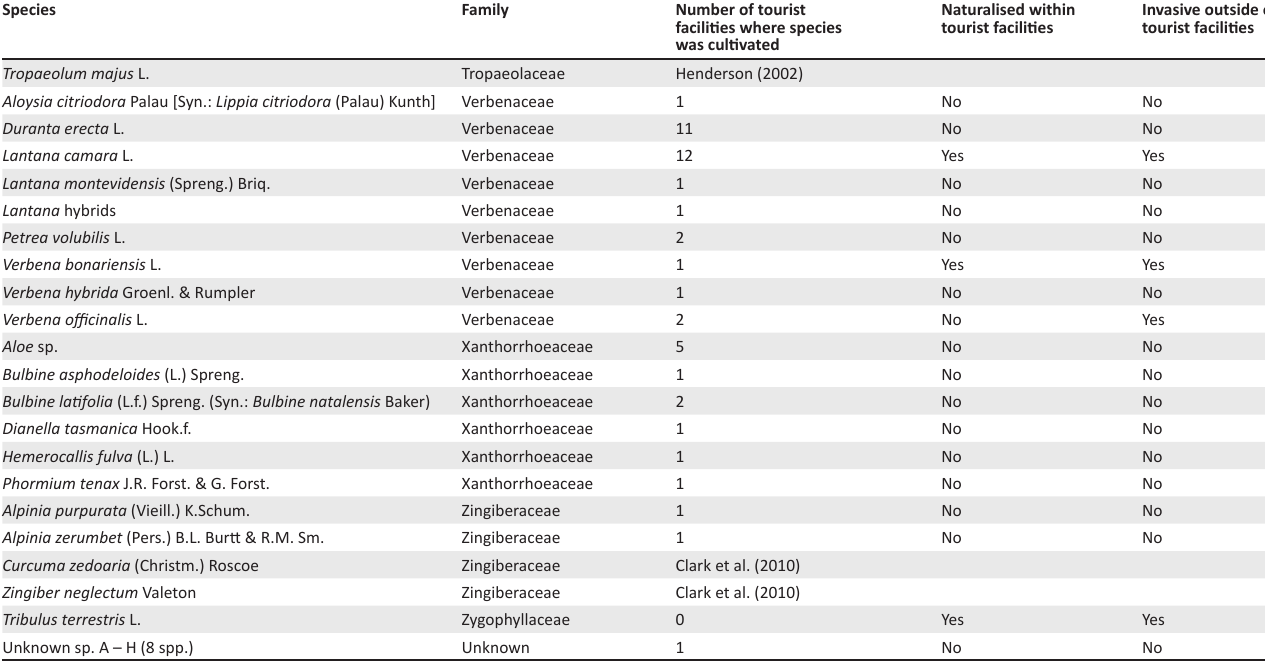
TABLE 1: (Continues...) Alien plant species, including some native plant species which may be growing outside of their natural range, recorded in the Serengeti-Mara ecosystem and immediate surrounds (excluding vegetable crops and grains).